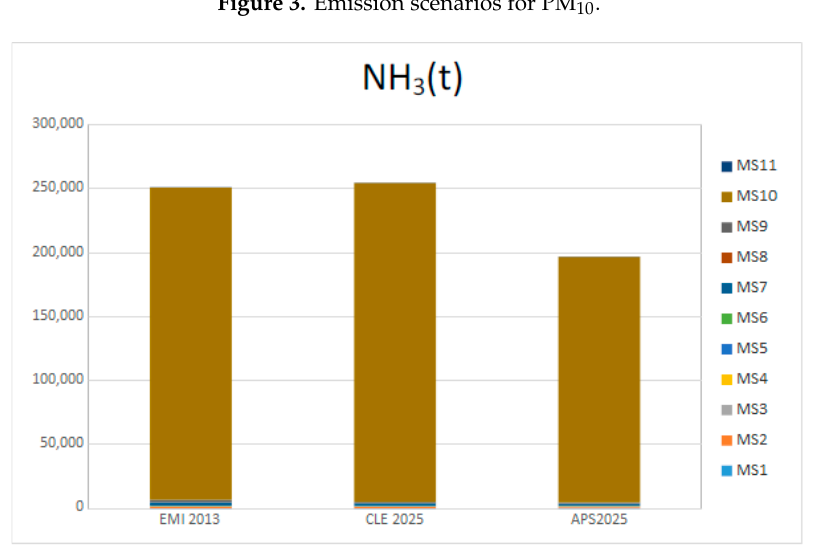
Figure 3. Emission scenarios for PM 10 .